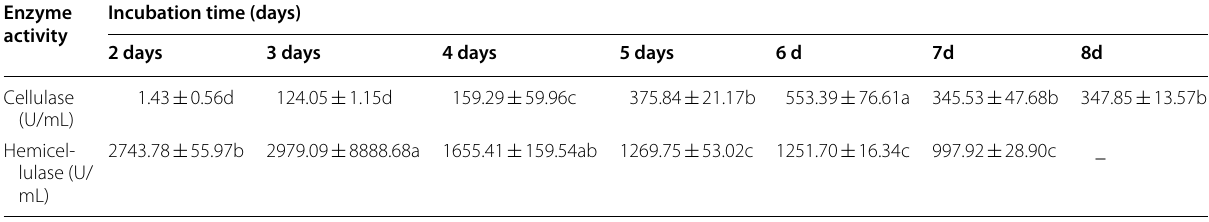
Table 2 Effect of incubation period on the activity of enzymes produced by the CS-1 strain